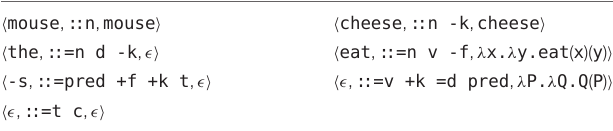
TABLE 2 | UMT minimalist lexicon for example grammar ( Figure 2